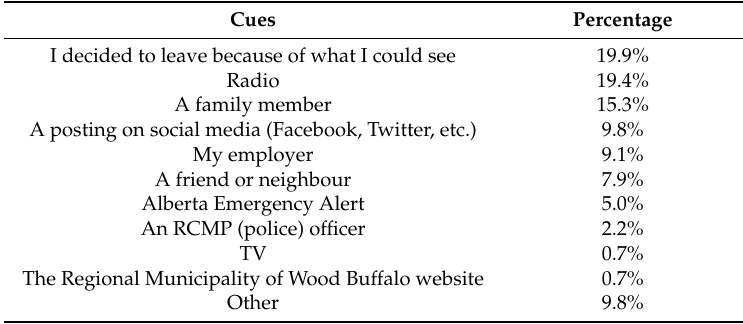
Table 3. How respondents learned that they would have to evacuate (n = 417).